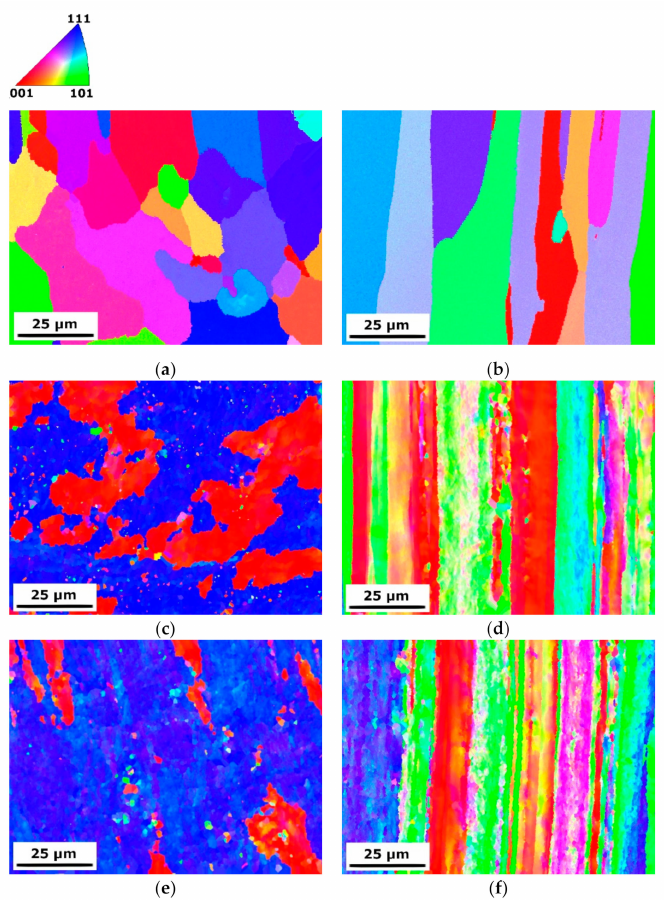
Figure 2. OIMs of the: ( a ) CG T6 transverse plane, ( b ) CG T6 longitudinal plane, ( c ) HE10 transverse plane, ( d ) HE10 longitudinal plane, ( e ) HE8 transverse plane and ( f ) HE8 longitudinal plane.